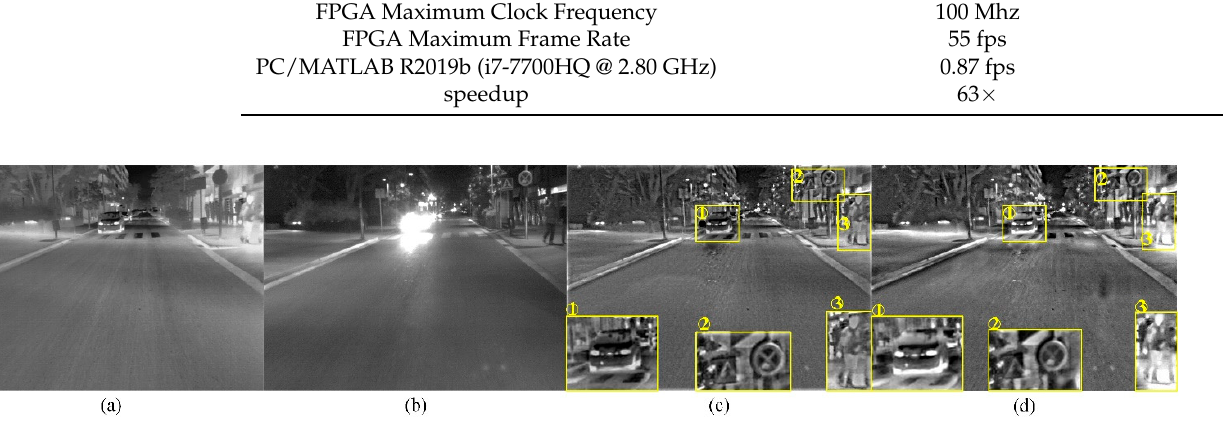
Figure 10. Test result in the glare scene. ( a ) Infrared image; ( b ) Visible image; ( c ) Fused image on FPGA; ( d ) Fused image on PC.